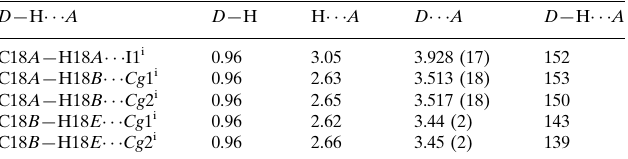
Hydrogen-bond geometry (A˚ , (cid:4)